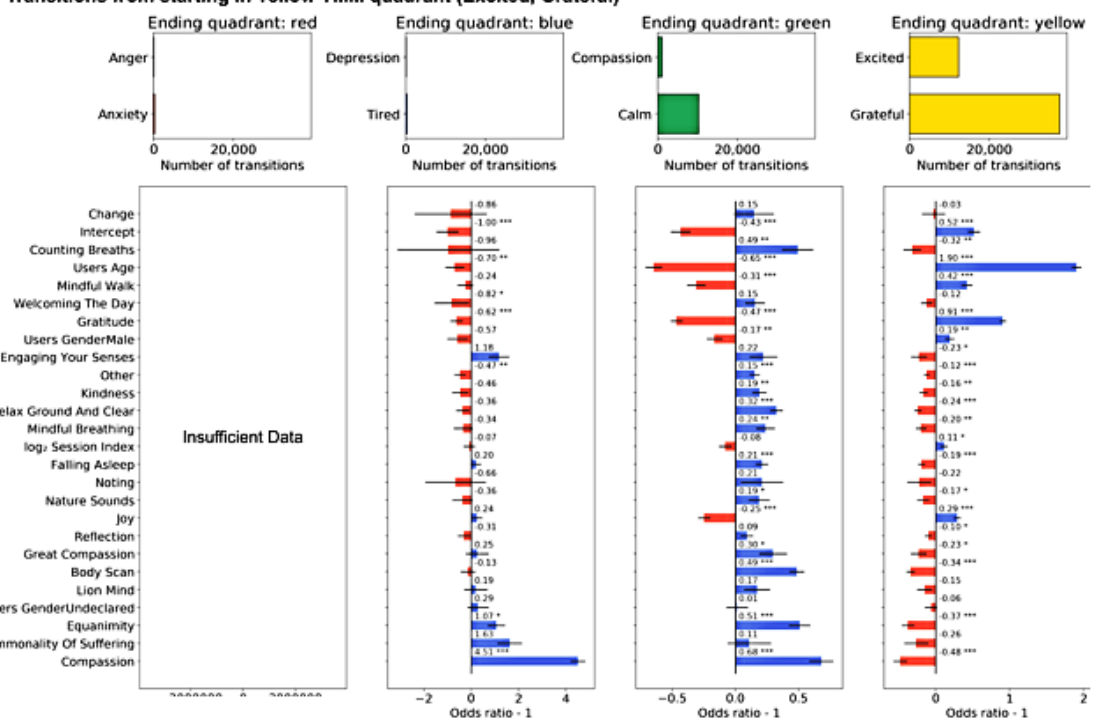
Figure 8. Transitions starting in Yellow Yale Mood Meter (YMM) quadrant model odds ratios. Sixteen generalized linear model fixed effect estimated odd ratios and P values (<.001***, <.01**, and <.05*) for mindfulness and meditation activities, gender, session index, and y-intercept split by starting YMM quadrant. Blue bars indicate increased propensity to make a transition, whereas red bars indicate decreased probability of making the transition. There was not enough data to calculate estimates with confidence for transitions from Yellow (HEHP) to Red